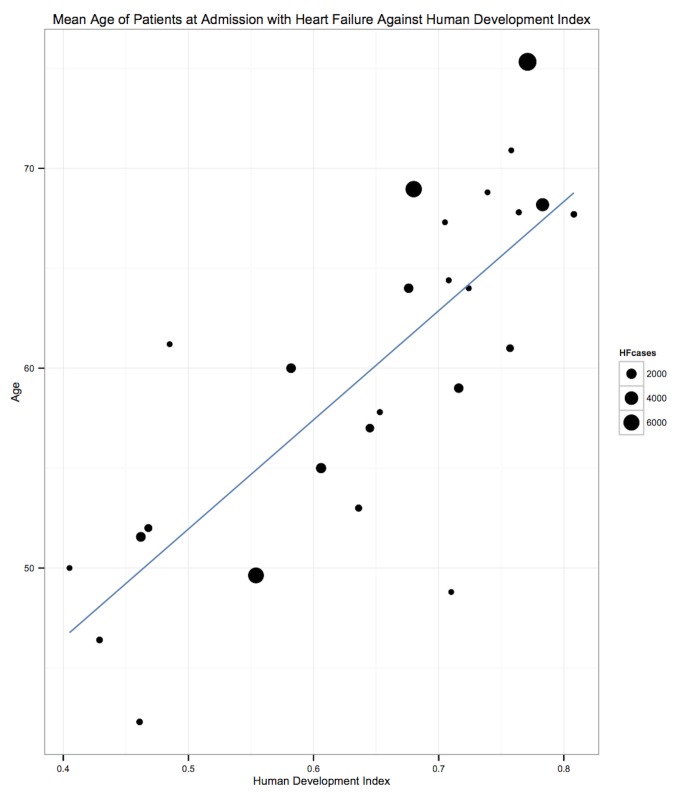
Correlation of age and human development index, by country.
r = 0.71, p<0.001. The HDI is a measure produced by the United Nations Development Programme that incorporates gross national income per capita, life expectancy, and time spent in education. It serves as a single statistic that provides a comparable measure of development across nations. HF, heart failure.